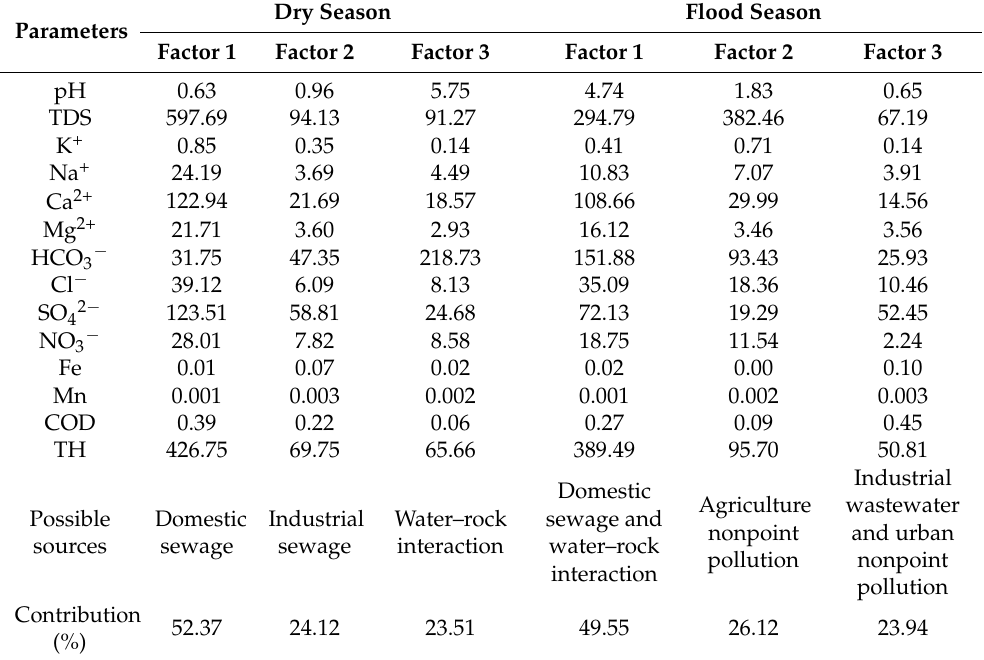
Table 4. Source profiles obtained from the PMF